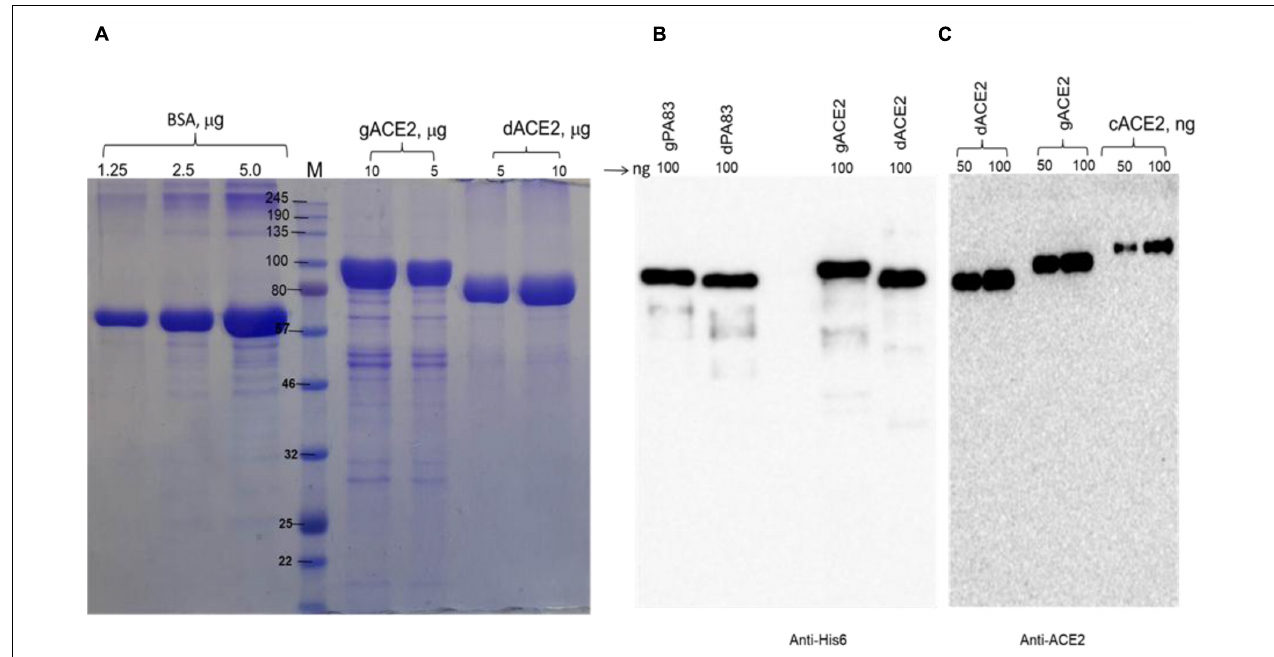
FIGURE 2 | Sodium dodecyl-sulfate polyacrylamide gel electrophoresis (SDS-PAGE) (A) and Western blot (B,C) analysis of plant produced, Ni-NTA resin purified gACE2 or dACE2 proteins. Glycosylated and deglycosylated plant produced ACE2 proteins were purified from N. benthamiana plant using HisPur TM Ni-NTA resin. gACE2: 5 or 10 µ g purified gACE2 protein was loaded into well; dACE2: 5 or 10 µ g purified dACE2 proteins were loaded into well. Bovine serum albumin (BSA) standards: 1.0, 2.5, and 5.0 µ g BSA protein was loaded as a standard protein. (B) Membrane was probed with anti-His6 antibody. gPA83 (plant produced glycosylated protective antigen of B. anthracis , MM ∼ 100 kDa) and dPA83 (deglycosylated protective antigen of B. anthracis , MM ∼ 90 kDa) proteins were used as a standard. (C) Membrane was probed with a purified anti-human monoclonal ACE2 antibody (Cat. No. 375801, BioLegend, CA, United States). cACE2: recombinant human ACE2, amino acid (Gln18—Ser740) (Accession: NM_021804.1) was expressed in CHO cells as His tagged protein (cat. no. 792004, BioLegend, CA, United States). The image was taken using a highly sensitive GeneGnome XRQ Chemiluminescence imaging